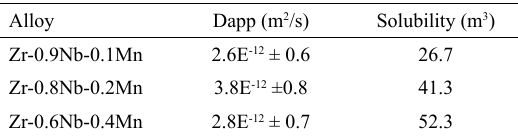
Table 2. Hydrogen diffusion parameters obtained by TDS